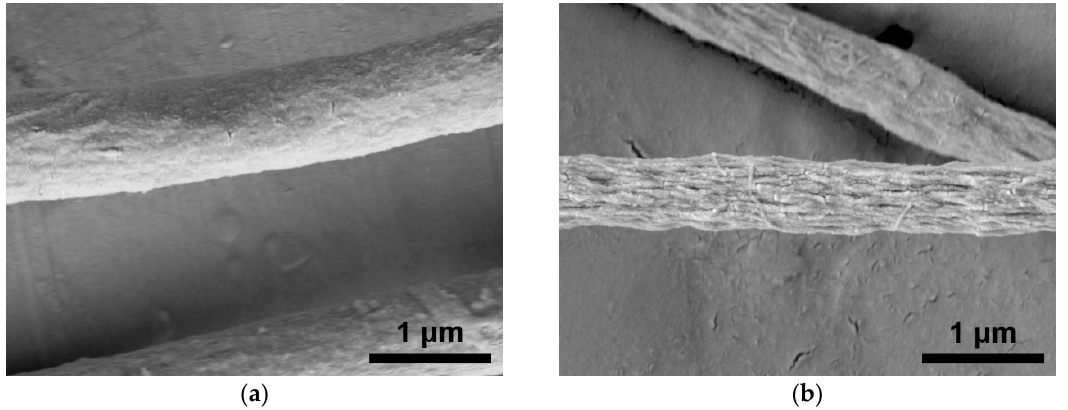
Figure 2. SEM images of the cellulose nanocrystal (CNC)-reinforced polymethylmethacrylate (PMMA) fibers ( a ) before and ( b ) after etching PMMA.